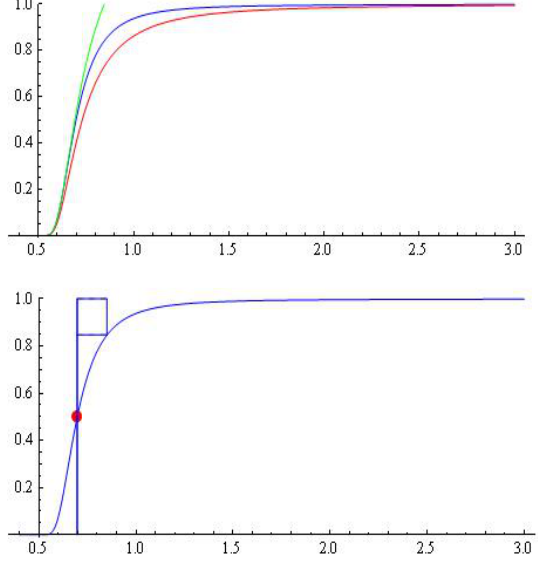
Fig. 10. a) The two-sided bounds (17) for α = 0 . 6; β = 0 . 1; q = 0 . 4 ; b) The model Q 1 ( t ) for α = 0 . 6; β = 0 . 1; q = 0 . 4 , t 0 = 0 . 698075 ; H–distance d = 0 . 153113